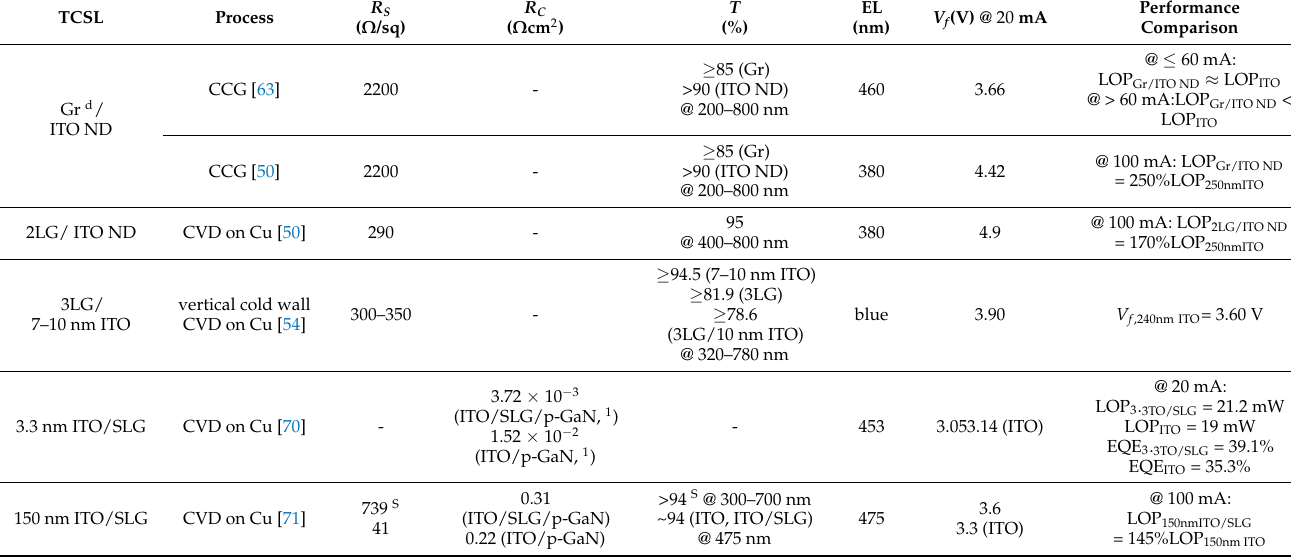
Table 3. Usage of hybrid graphene TCSLs combined with various ITO configurations: nanodot (ND), thin and thick